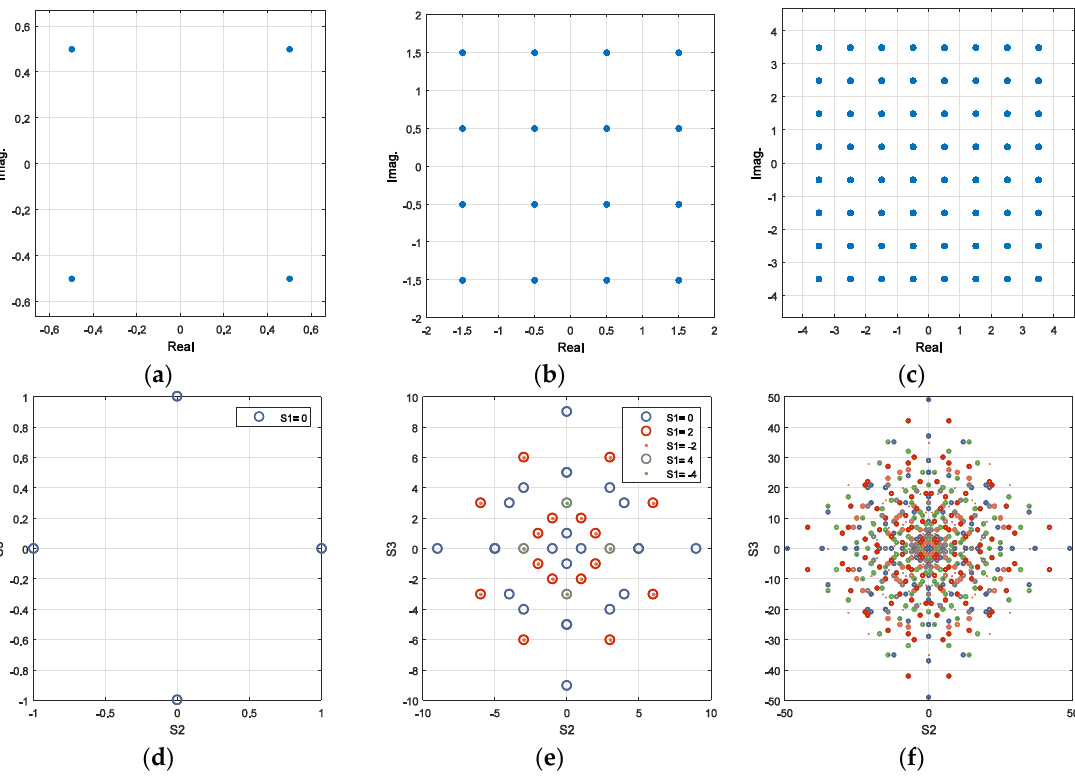
Figure 1. Examples of different single- and dual-polarization (SP and DP) constellations in the Euclidean and Stokes space. Since the Stokes transformation is a 3-D real space, colors are used to identify 𝑆 1 dimension. We plot only one dimension of the Euclidean space since it is a 2-D complex space where both dimensions have the same constellation. ( a ) SP-QPSK in Euclidean space; ( b ) SP-16QAM in Euclidean space; ( c ) SP-64QAM in Euclidean space; ( d ) DP-QPSK in Stokes space; ( e ) DP-16QAM in Stokes space; ( f ) DP-64QAM in Stokes space (legend is omitted and colors are repeated for different cases of 𝑆 1 ).